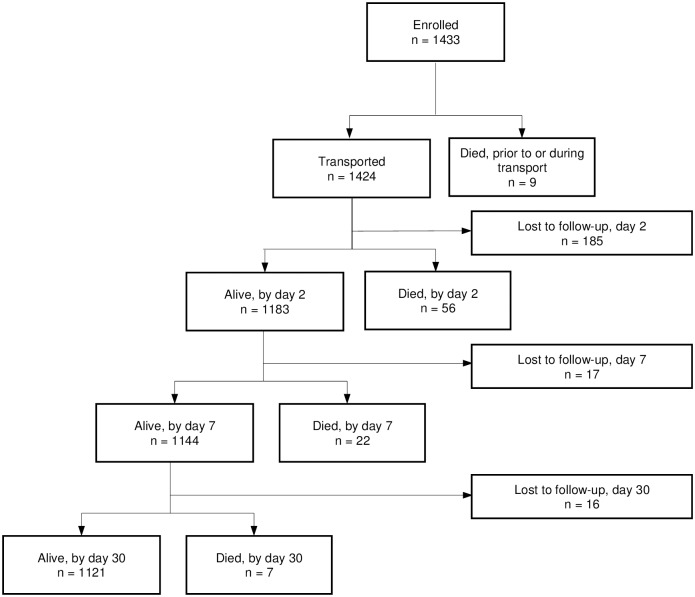
Flow diagram of patient study cohort.